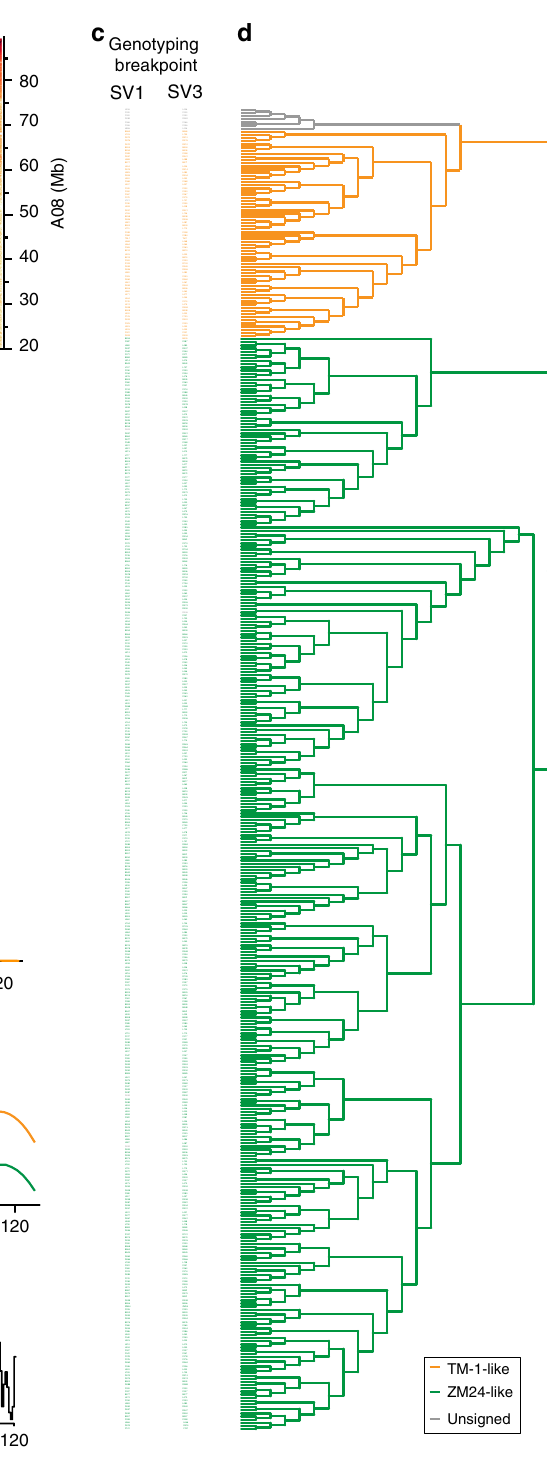
Fig. 3 Genetic effect of inversions present on A08. a Large-scale inversions (SV1, SV2, and SV3) on A08 between TM-1 and ZM24. b ZM24 Hi-C data mapped to TM-1 A08. c Genotyping of breakpoints in SV1 and SV3. The 421 accessions colored by the A08 inversion allele (orange, TM-1-like allele; green, ZM24-like allele; grey, unsigned) as assessed by the breakpoints for SV1 and SV3. The accessions were ordered based on the haplotype clustering shown in ( d ). d Haplotype clustering based on 315,868 SNPs (MAF ≥ 0.05) genome-wide, revealing two distinct clusters (TM-like and ZM24-like groups), which identically matched the distributions of the two A08 inversion alleles. e Principal component analysis of 421 accessions. f Genetic differentiation (F ST ) between the TM-1-like group and ZM24-like group. g Haplotype diversity for the TM-1-like and ZM24-like group. h Local impact of large inversions on meiotic recombination rate using a RIL population derived from a cross of TM-1 and ZM24. Black line, cM/Mb values across the chromosome; Colored boxes, location of inversions. Source data of ( e – h ) are provided in a Source Data fi